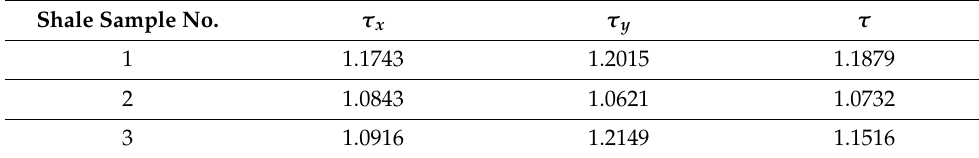
Table 4. Tortuosity of shale fracture surface morphology.